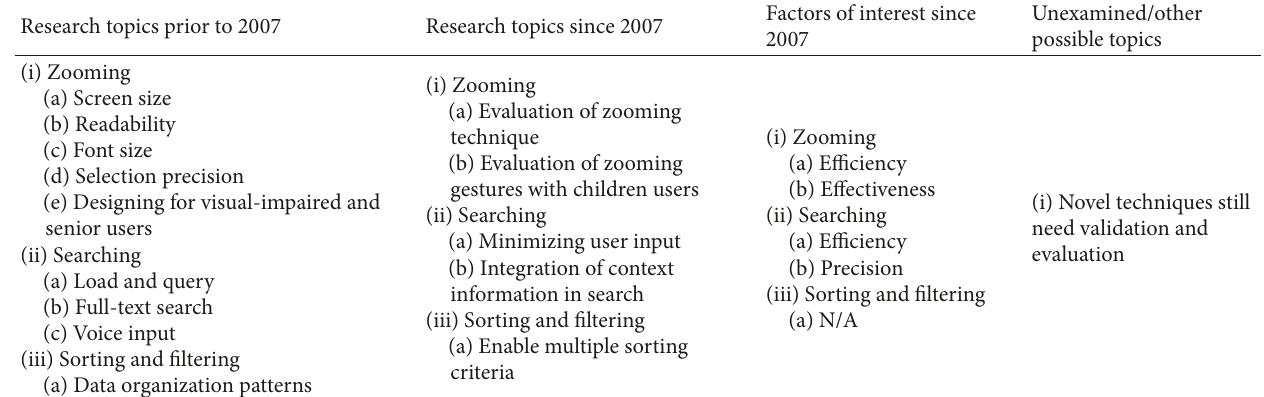
Table 12: Information control research.